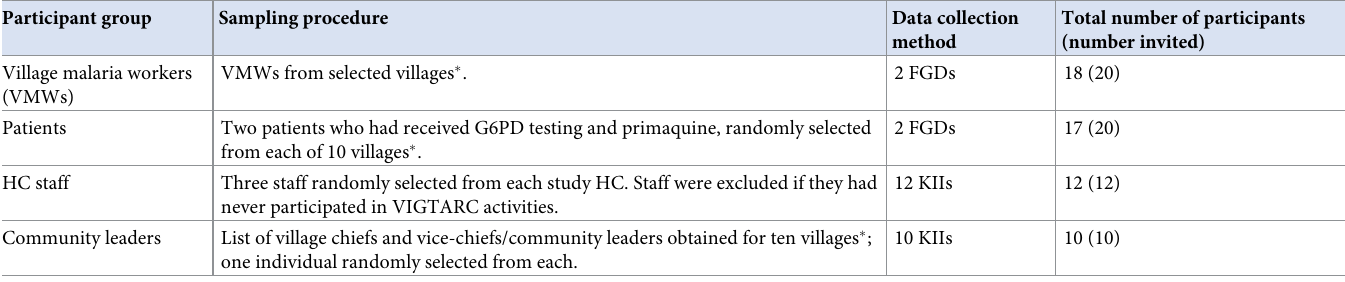
Table 1. Sampling frame for the qualitative data